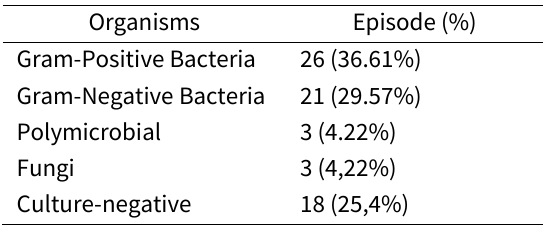
Table 1. CAPD Peritonitis Culture Results in 2017 Organisms